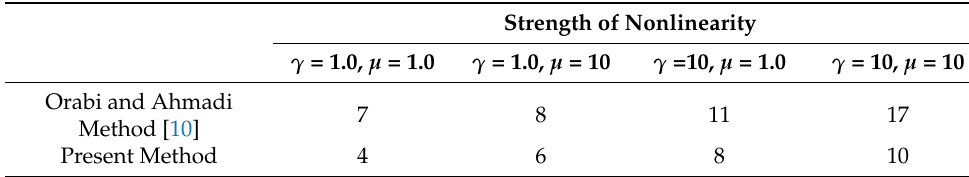
Table 2. Comparison of the number of iterations.